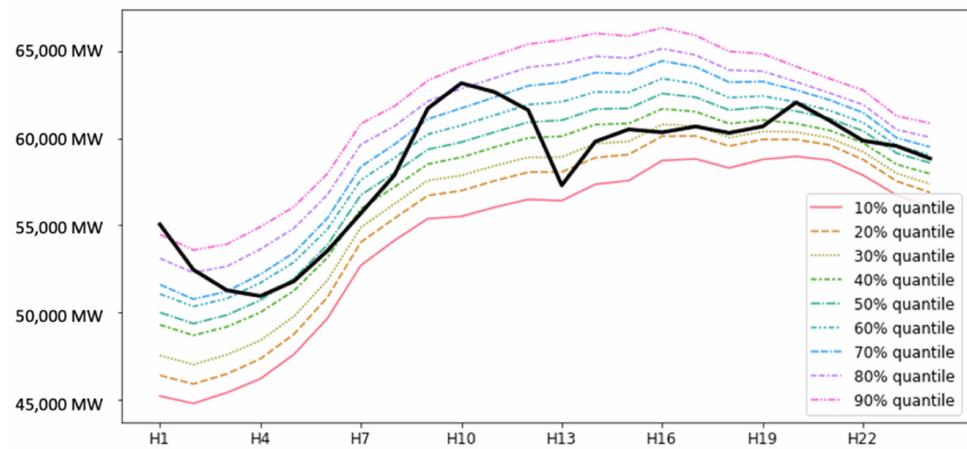
Figure 7. The proposed weak net load forecasting results with quantile values between 10~90%. The black line is actual net